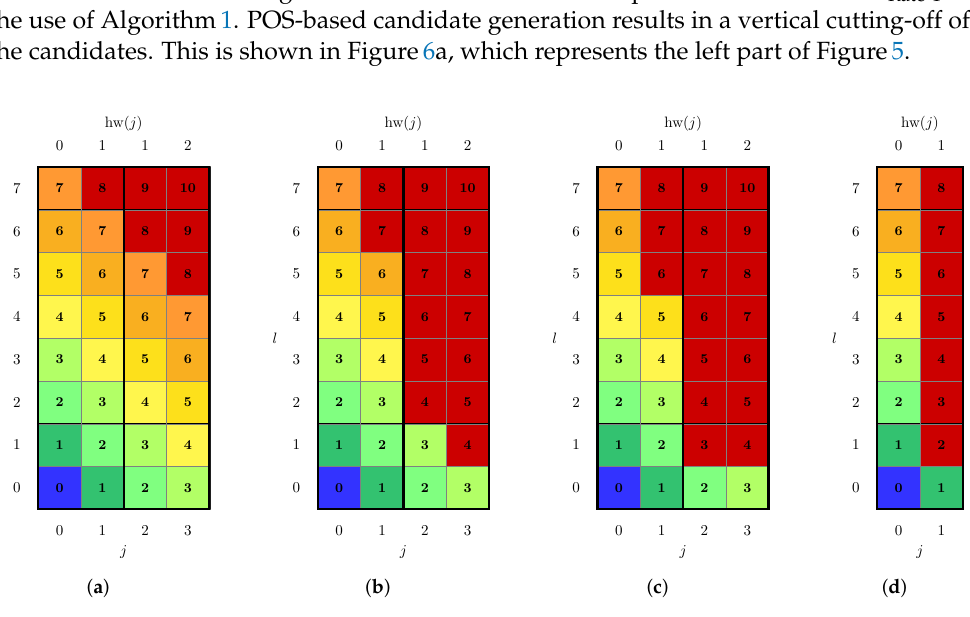
Figure 6. Smallest possible candidate indices m l , j for L = 8, calculated by ( a ) POS algorithm with S Rate-1 = 2, ( b ) ExPOS algorithm with S Rate-1 = 2, k c = 3, ( c ) ExPOS algorithm with S Rate-1 = 2, k c = 4, ( d ) ExPOS algorithm with S Rate-1 = 1, k c =